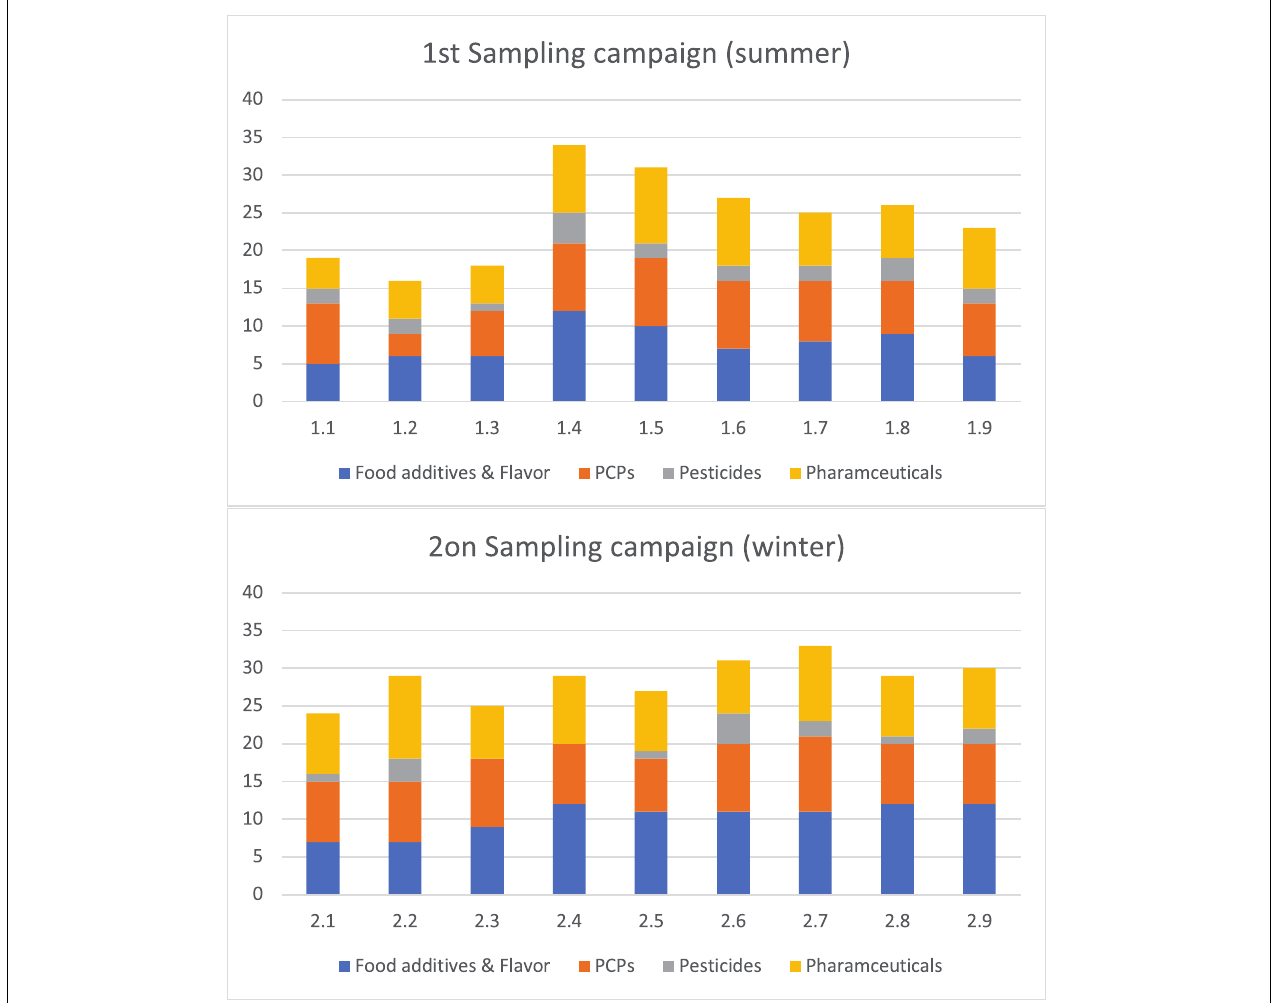
FIGURE 3 | Number of compounds tentatively identified in both sampling periods of this study, distributed in